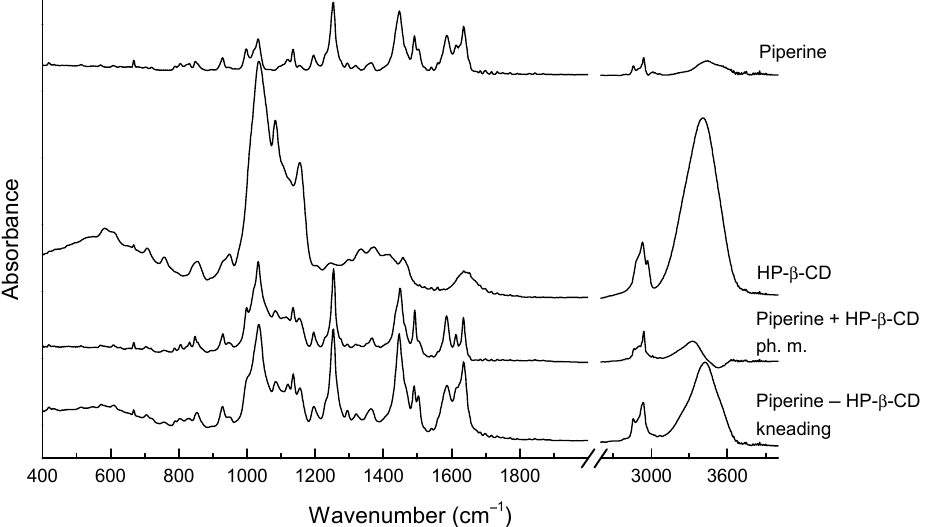
Figure 5. The experimental FT-IR of piperine, HP- β -CD, the mixture with HP- β -CD obtained by kneading method and physical mixture.